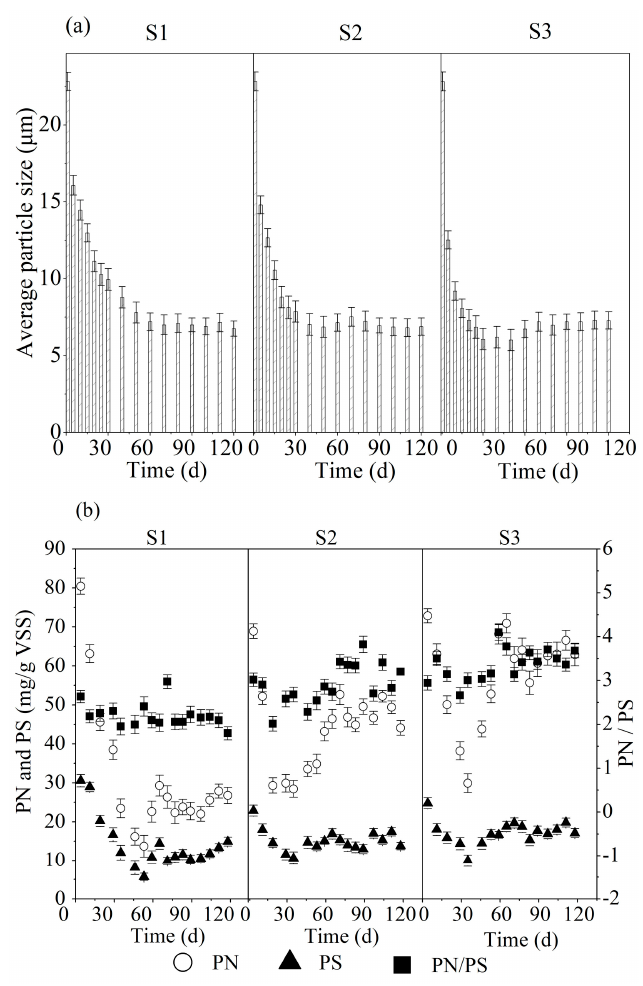
Figure 3. Sludge characteristics of the AnMBR under different cycle frequencies. ( a ) the sludge particle size variation: ( b ) PN and PS variation in the BEPS. Table 2. The sludge characteristics of the AnMBR at different sludge cycle frequencies (mean ± standard deviation).